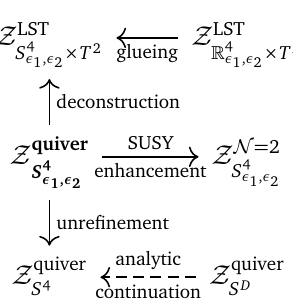
Figure 1: The N = 1 toroidal-quiver 4D partition function and its various